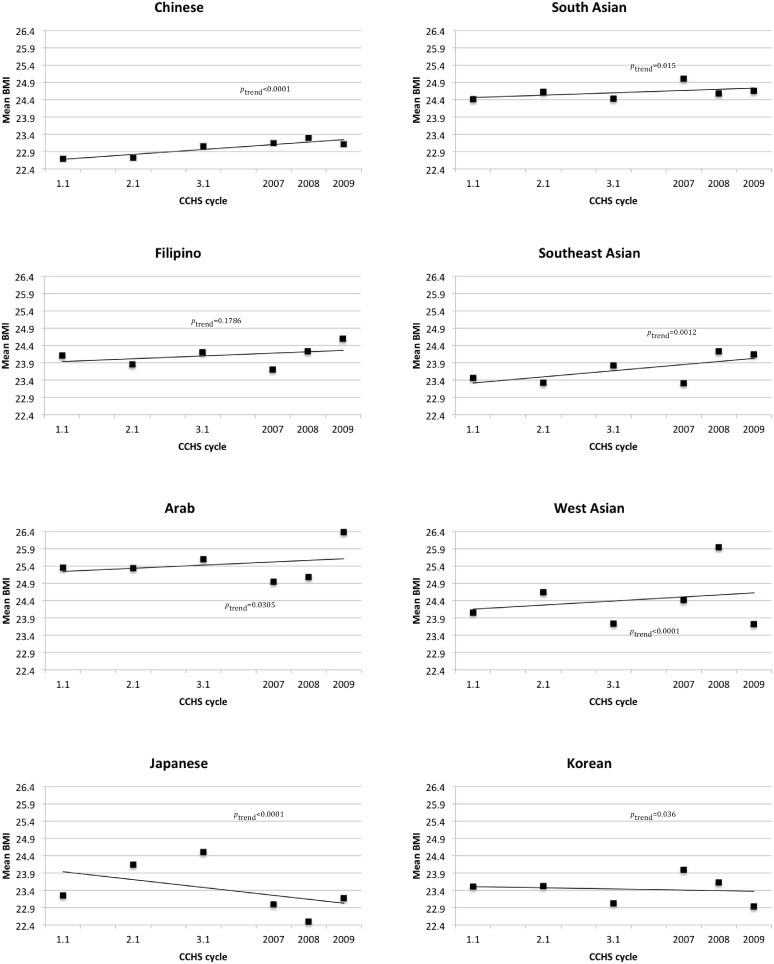
Weighted-unadjusted mean BMI across CCHS cycles (2001–09) by Asian sub-groups.